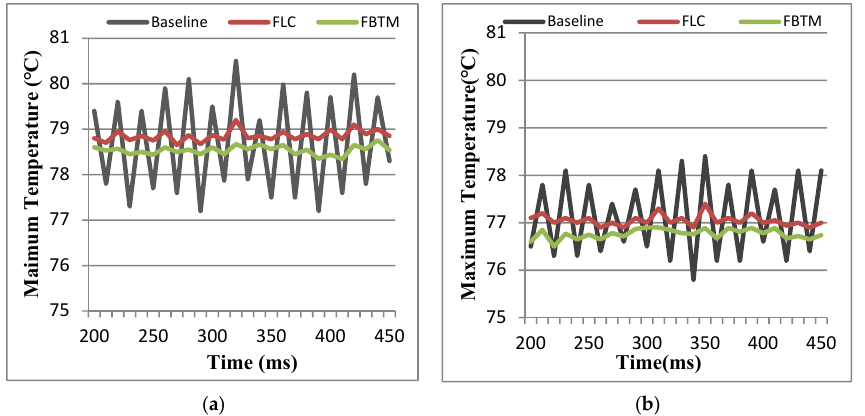
Figure 6. Comparison of the transient maximum temperature. ( a ) Executing the mem2 program set. ( b ) Executing com2 program set.